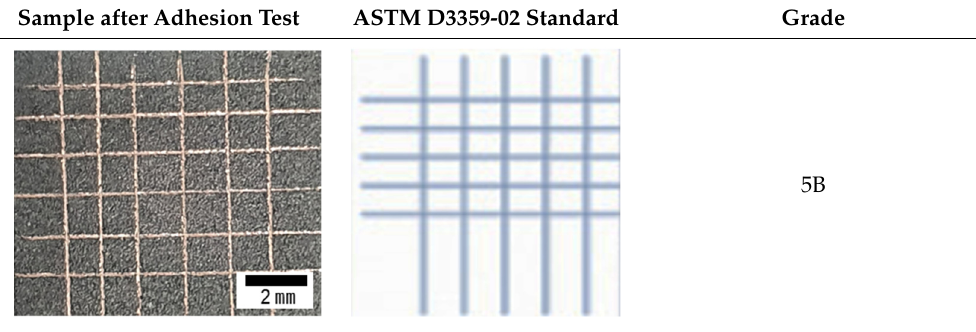
Figure 3. The cross-sectional images at ( a ) high- and ( b ) low-magnification with ( c ) EDS mapping.